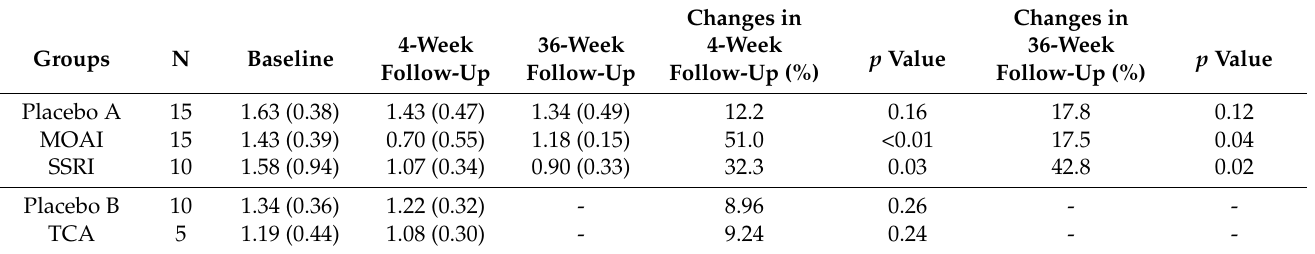
Table 1. Changes in weekly preference ratio ( ± SD) with consumption of area nut water after antidepressants treatment in mouse mode (follow-up at 4 and 36